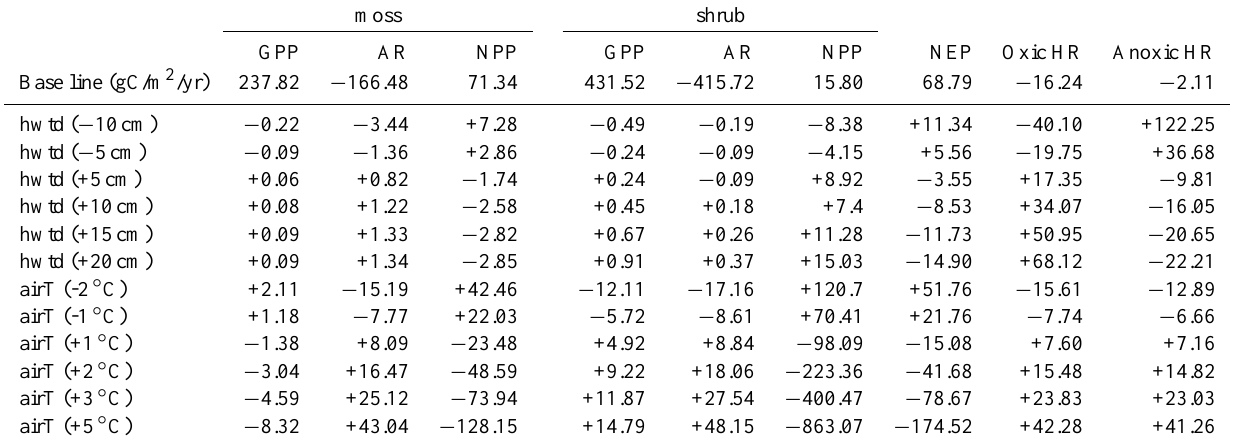
Table 4. The sensitivity of simulated GPP, autotrophic respiration (AR), NPP and oxic and anoxic heterotrophic respiration (HR) expressed in percent change relative to the baseline simulation (observed environmental variables: hwtd and airT are hourly mean water table depth and air temperature). A negative sign indicates a decrease relative to the baseline while a positive sign indicates an